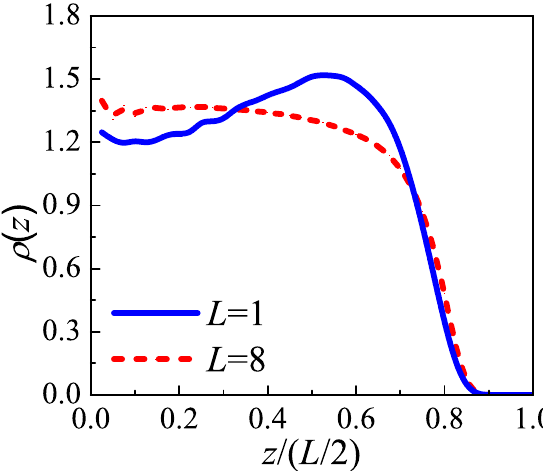
Figure 3. The density profiles versus the distance away from the surface. The distance away from the surface is scaled by half of loop length, i.e., L /2. The blue solid lines and red dash lines represent the tight fold ( L = 1) and loose loop ( L = 8),